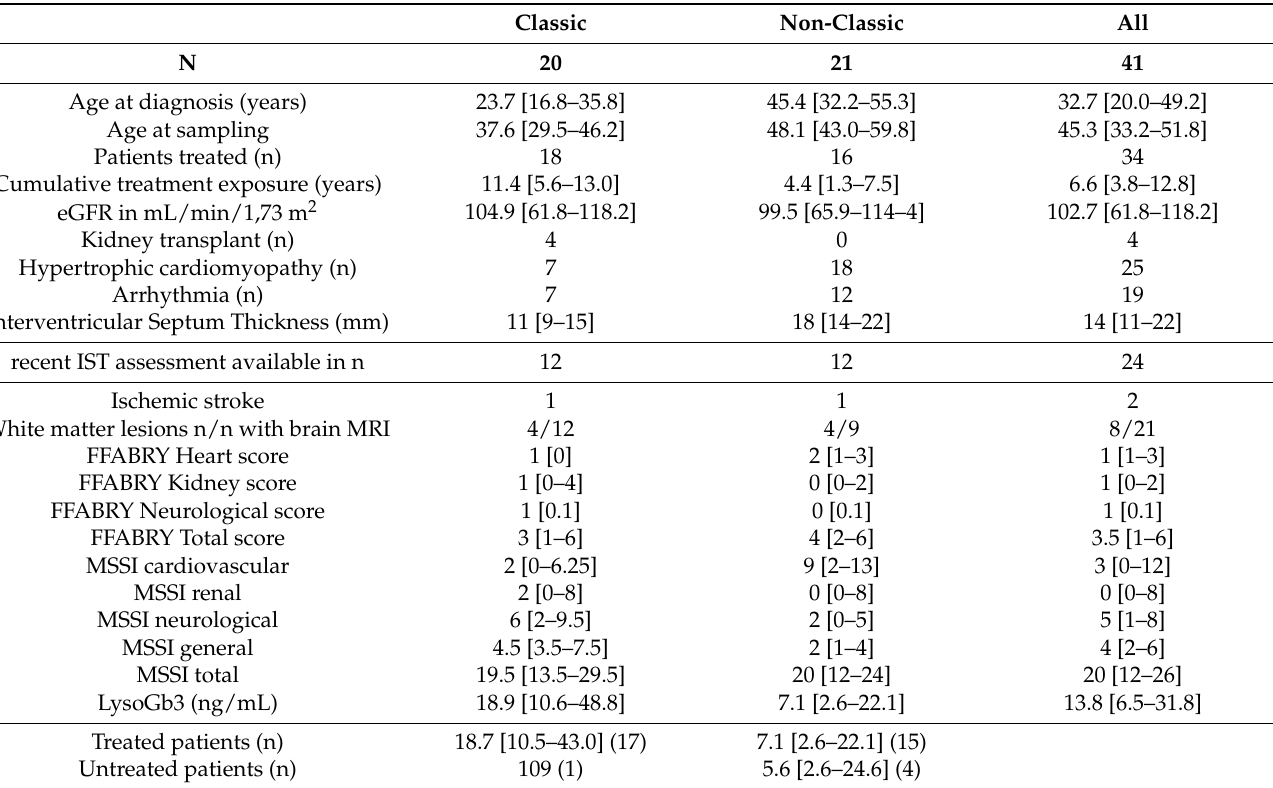
Table 1. Characteristics of patients (median [interquartile]; eGFR = estimated glomerular filtration rate according to the CKD-EPI equation; IST: interventricular septum thickness; MSSI Mainz Severity Score